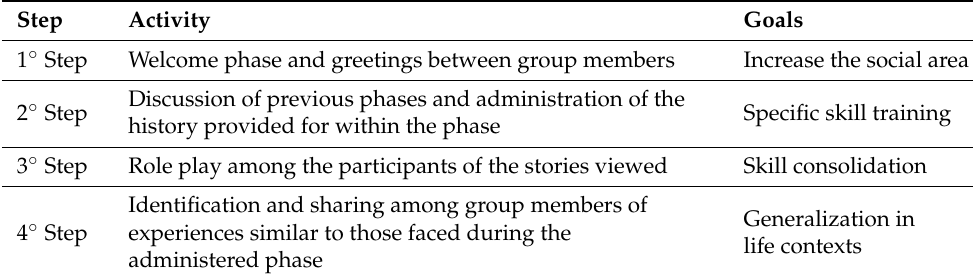
Table 2. Training sessions.